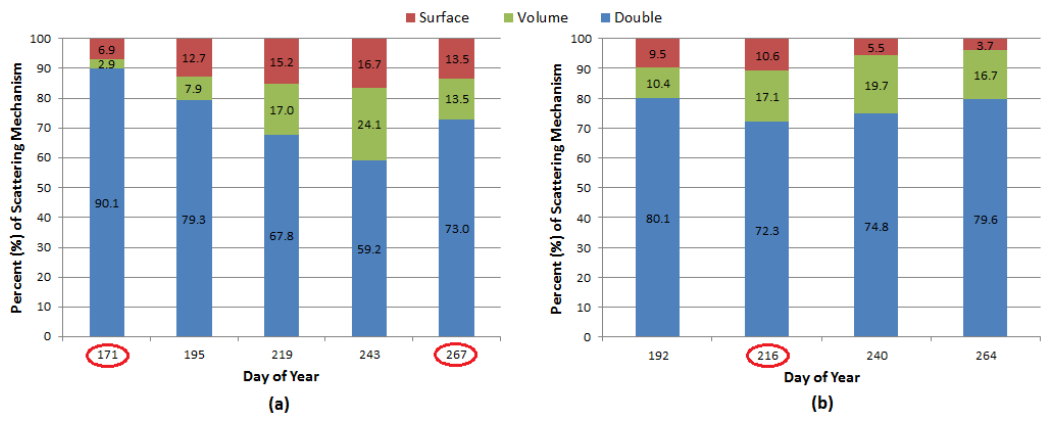
Figure 17. Wetlands Freeman-Durden decomposition for (a) 41° and (b) 26° incidence angles based on RADARSAT-2 fine-quad beam modes. Note that circled days coincide with polarization response plot and Cloude-Pottier decomposition